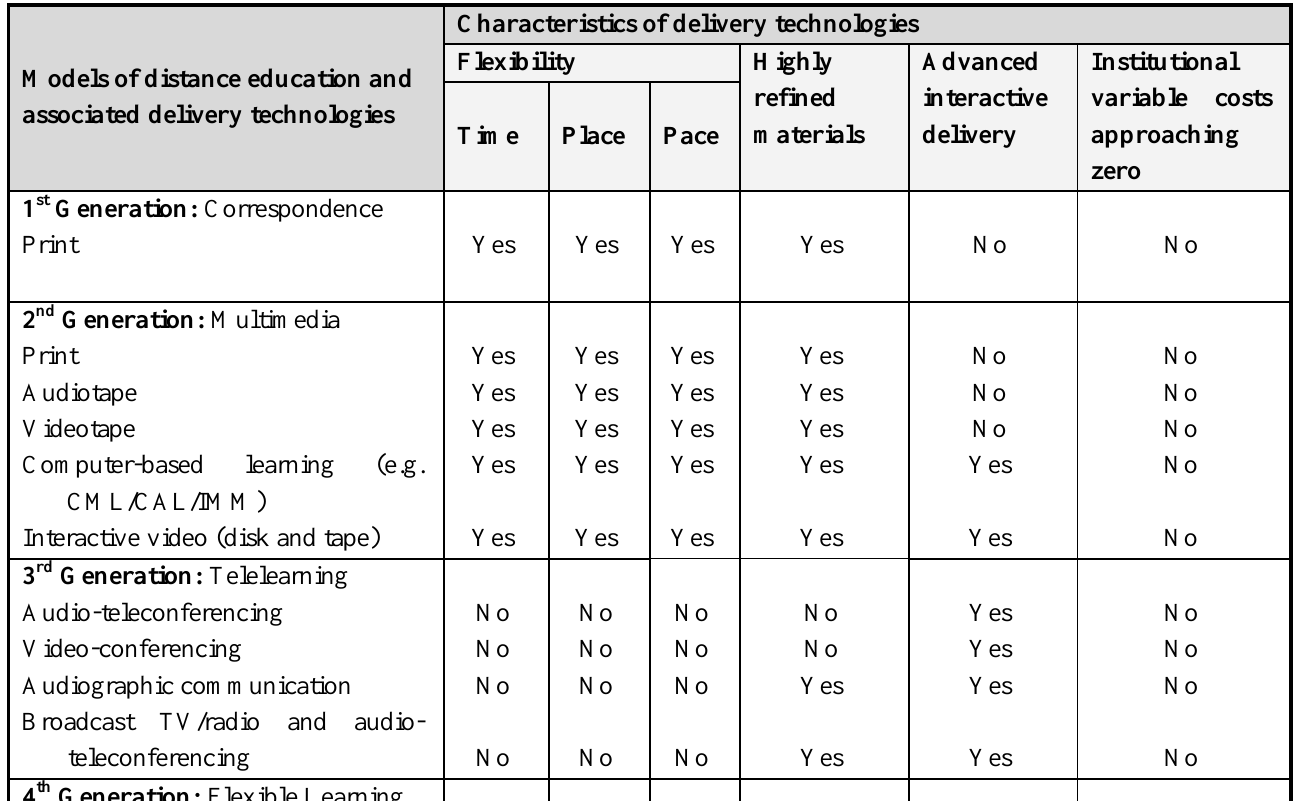
Generations of Distance Education (Taylor, 2001) Models of distance education and associated delivery technologies